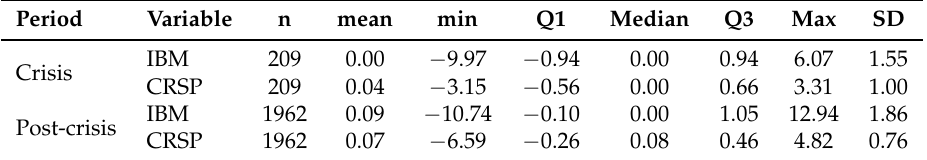
Table 2. Summary statistics in percentage of IBM and CRSP during crisis and post-crisis